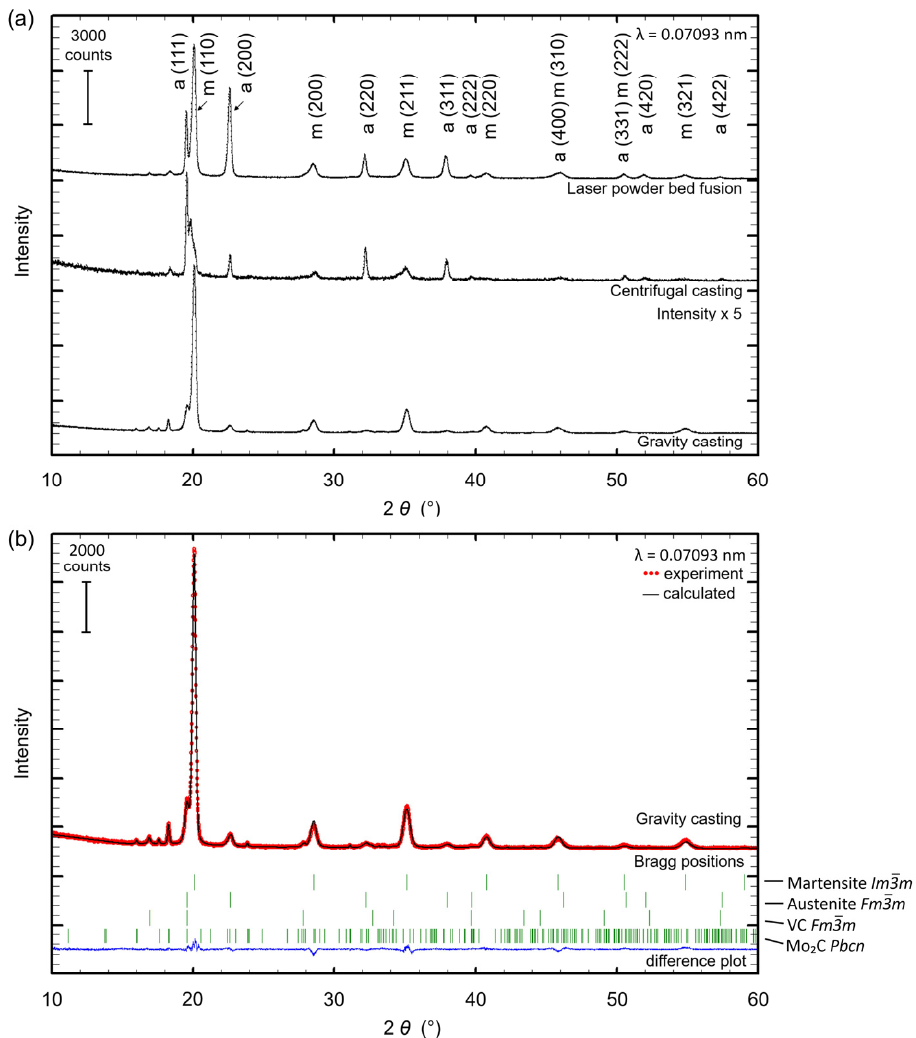
Figure 3. ( a ) XRD patterns for Fe85Cr4Mo8V2C1 processed by laser powder bed fusion, centrifugal casting and gravity casting. For reasons of clarity, only austenite and martensite are indexed; ( b ) Rietveld plot of the sample produced by gravity casting with the contributing phases (from top to bottom) martensite, austenite, VC and Mo 2 C as symbolized by the vertical, green Bragg position markers. The difference plot at the bottom of the graph (continuous, blue line) displays the quality of the calculated fit (continuous, black line) in comparison with the observed data (dotted, red